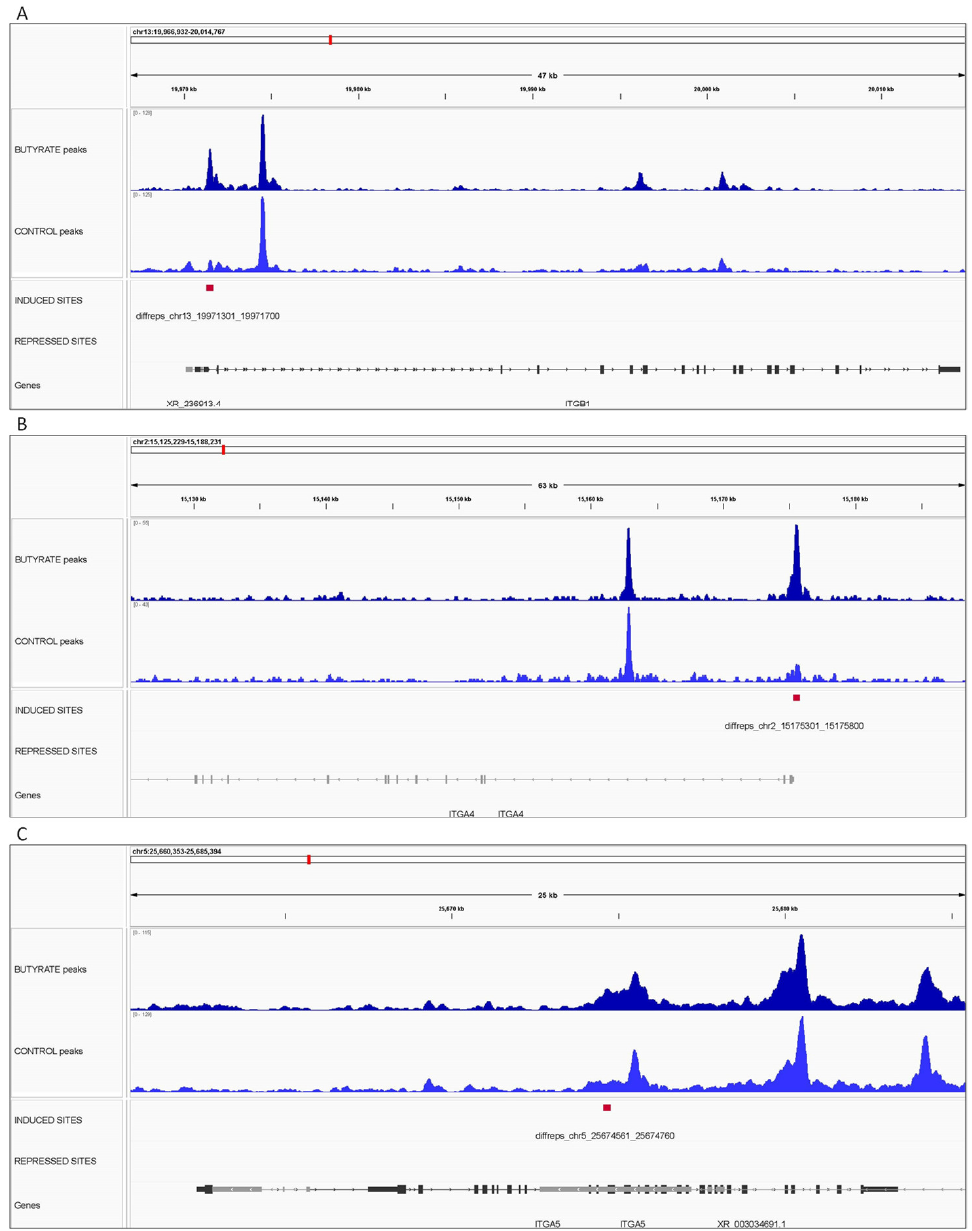
Figure 6. Integrative genomics viewer (IGV) screenshot of CTCF peaks (BT and CT) and the butyrate-induced and -repressed differentially CTCF-binding sites for the ( A ) ITGB1 gene, ( B ) ITGA4 gene, and ( C ) ITGA5 gene. The X -axis represents the chromosomal location with the size bar given in kb.